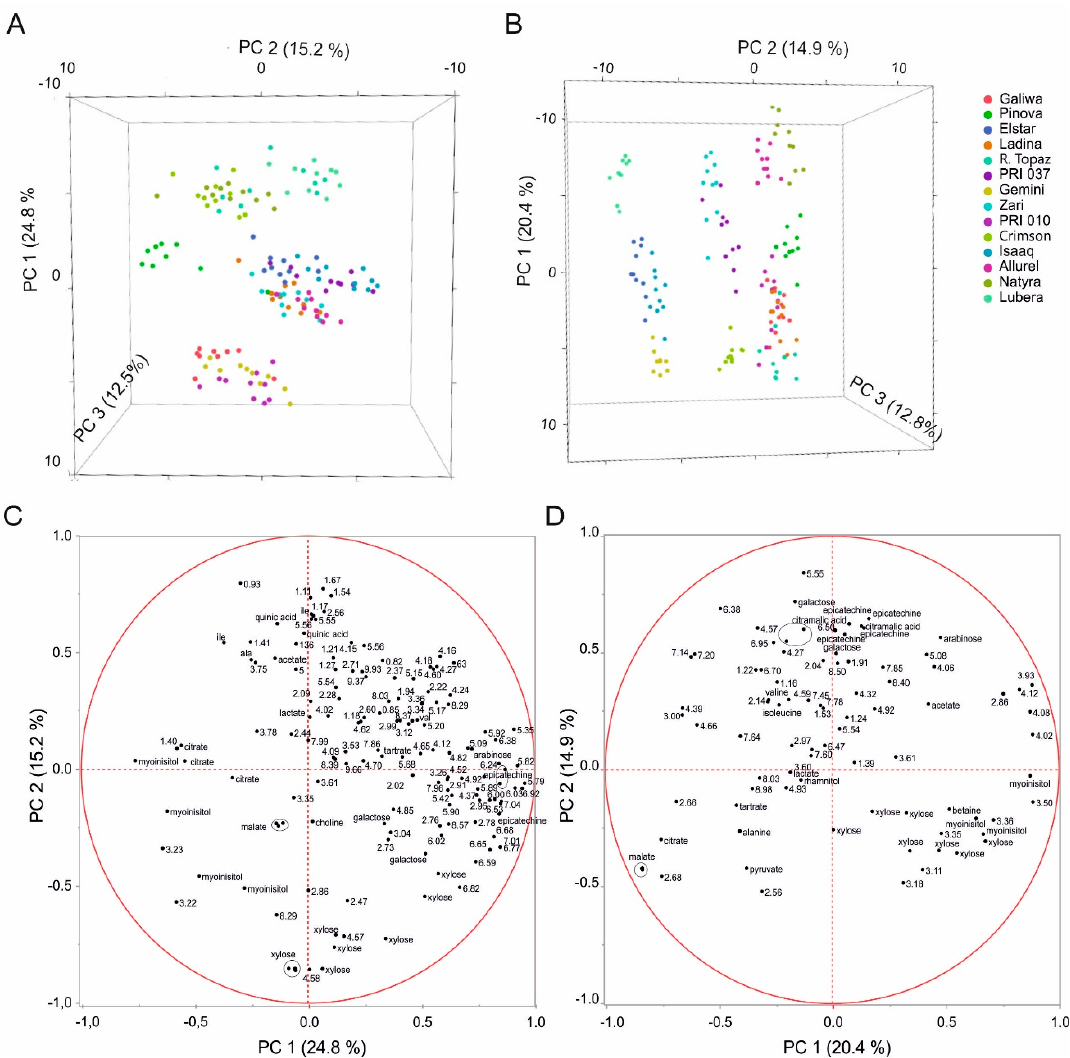
Figure 3. PCA of peel ( A ) and pulp ( B ) omitting sugars from the analyses. ( A,B ) Scores plot showing three PCs (principal component) with their respective variation. Peel: R 2 X (PC1) = 24.8%, R 2 X (PC2) = 15.2%, R 2 X (PC3) = 12.5%, Q 2 (PC1) = 22.5%, Q 2 (PC2) = 12.7, Q 2 (PC3) = 12.1. Pulp: R 2 X (PC1) = 20.4%, R 2 X (PC2) = 14.9%, R 2 X (PC3) = 12.8%, Q 2 (PC1) = 16.1%, Q 2 (PC2) = 11.1, Q 2 (PC3) = 9.8. ( C,D ) Corresponding loadings plot. Loadings are labeled with substance name or ppm value. In case of overlapped resonances, only the ppm value is given.